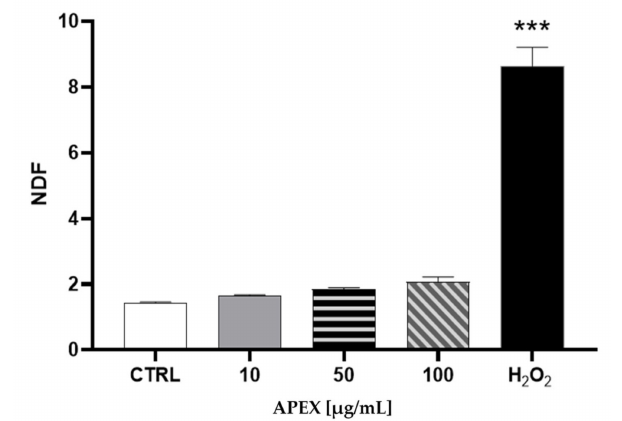
Figure 2. Effect of APEX on U937 nuclear DNA. Cells were treated as detailed in Figure 1 and then assayed for DNA damage. The extent of DNA breaks is expressed as NDF (see the Methods section). The effect of H 2 O 2 (100 µ M for 2 h) included as a positive control is also shown. One-way ANOVA with Dunnett’s post hoc test. *** p < 0.0001 CTRL vs. H 2 O 2 100 µ